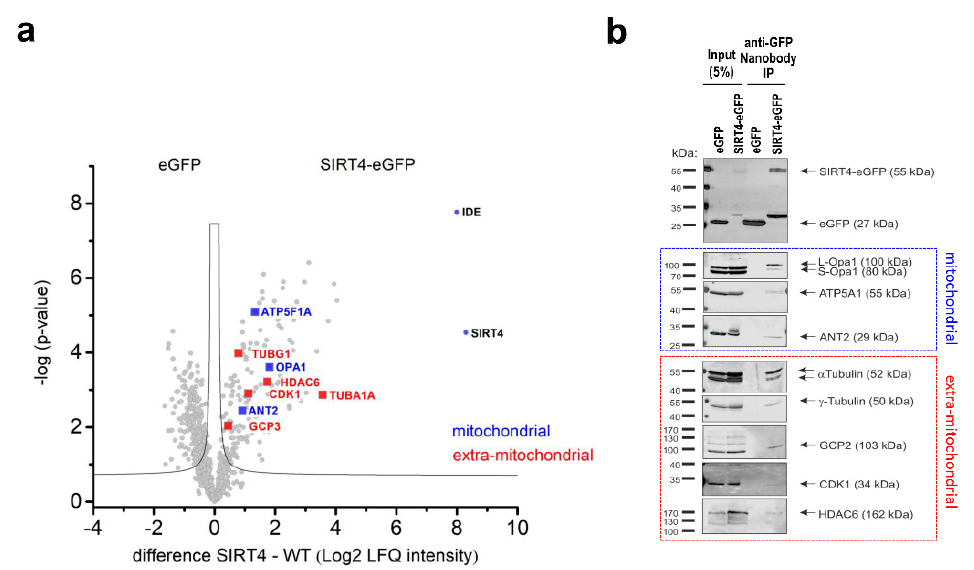
Figure 5. Analysis of the mitotic SIRT4 interactome by mass spectrometry. ( a ) Volcano plot analysis of mitochondrial and extra-mitochondrial proteins interacting with SIRT4. HEK293 cells stably expressing eGFP or SIRT4-eGFP ( n = 4 replicates each) were arrested in G 2 by the reversible CDK1 inhibitor RO3306 followed by release into mitosis (45 min after RO3306 wash out). Total cell lysates were subjected to anti-eGFP nanobody co-immunoprecipitations followed by their mass spectrometric analysis. ( b ) Anti-eGFP nanobody co-immunoprecipitations of selected mitochondrial and extra-mitochondrial SIRT4 interacting proteins as compared to eGFP controls. Total cell lysates analyzed in ( a ) were employed.